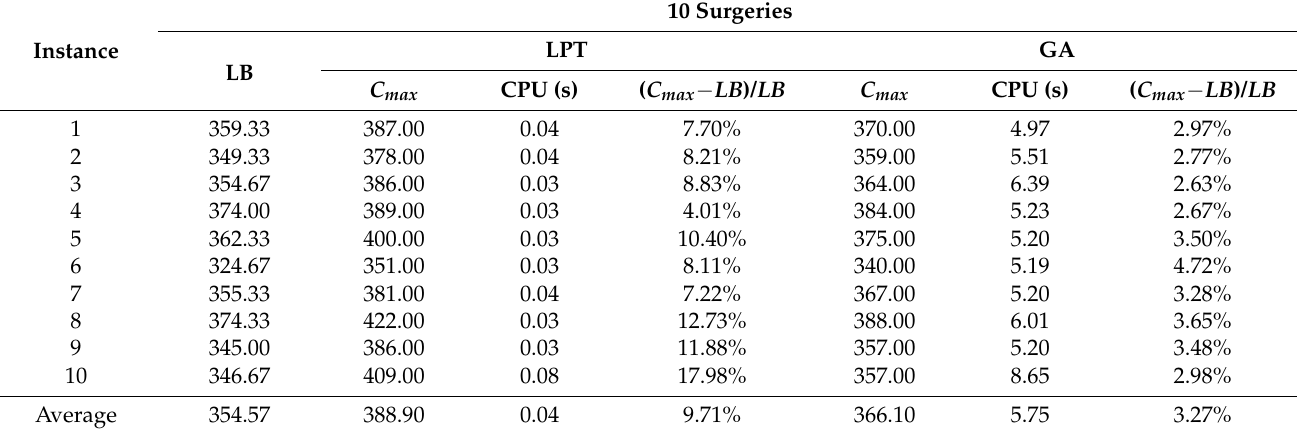
Table 5. Results of 10